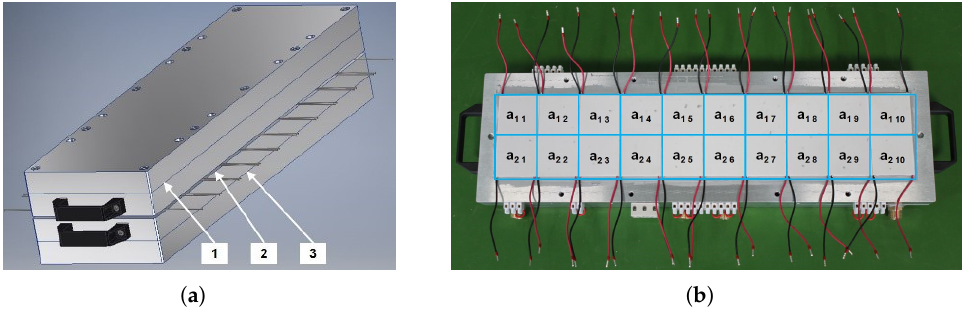
Figure 5. MTEG view with arrangement of individual TEGs; ( a ) model (1—hot side exchanger, 2—TEG layer, 3—cold side heat exchanger); ( b ) hot side exchanger prototype with